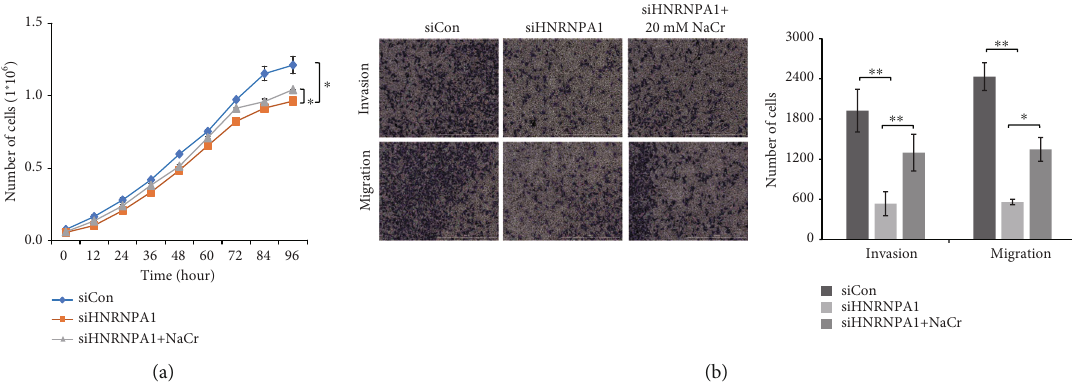
Figure 4: p300-mediated lysine crotonylation is involved in the regulation of HNRNPA1 on proliferation, invasion, and migration of HeLa cells. (a) E ff ects of HNRNPA1 or/and NaCr on HeLa cell proliferation were determined by CCK-8 kit. ∗ P < 0 : 05 . (b) Transwell assay was performed to determine the invasion and migration of HeLa cells treated with siHNRNPA1 or/and NaCr. The invasion and migration of HeLa cells were quanti fi ed using Image-Pro Plus 6.0. ∗ P < 0 : 05 ; ∗∗ P < 0 : 01 ; ∗∗∗ P < 0 : 001